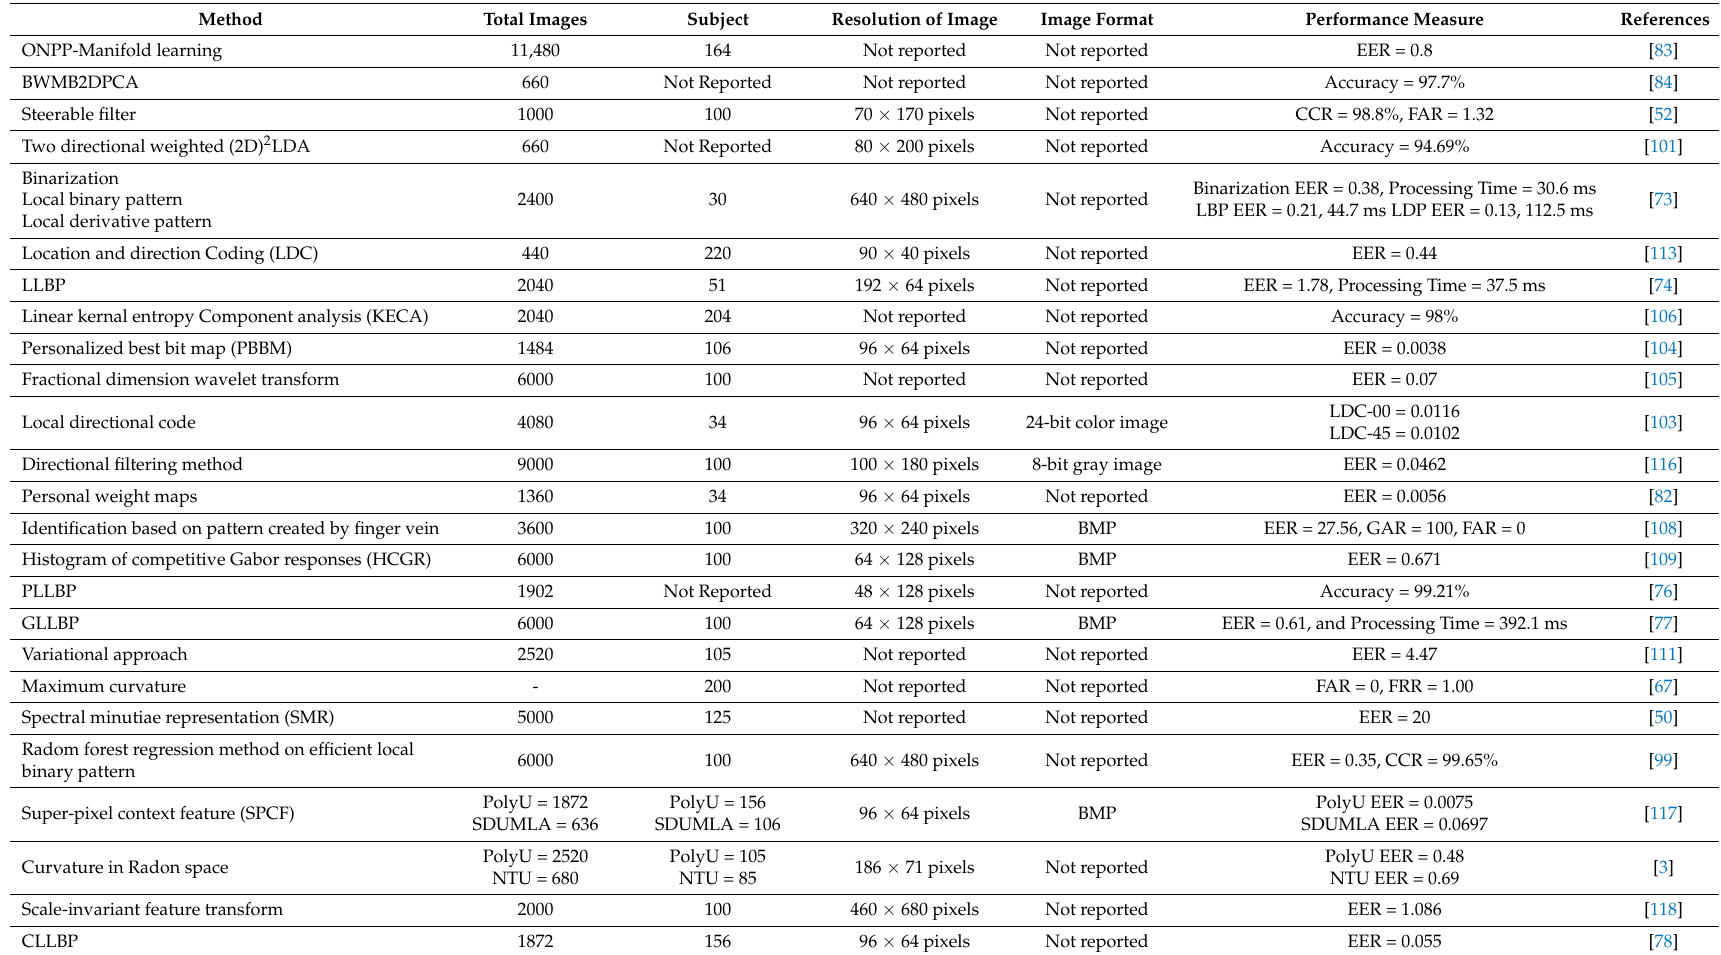
Table 5. Performance of some conventional finger vein recognition